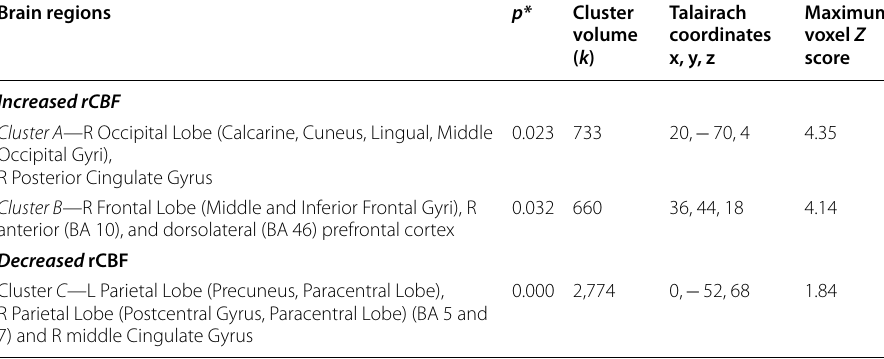
* p value of cluster significance; R right; L left; BA Brodmann Area